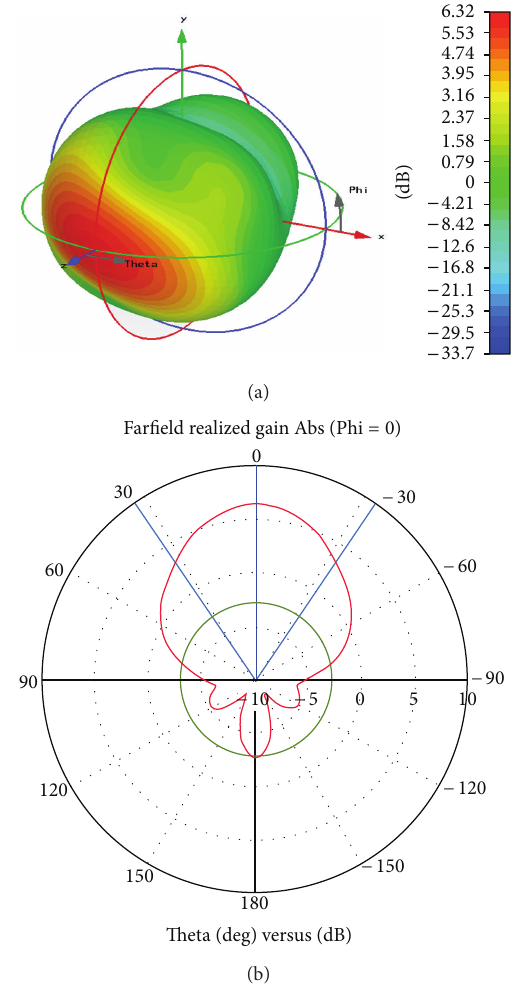
Figure 11: Radiation pattern of Archimedean spiral antenna: (a) 3D and (b) elevation cuts at phi = 0 ∘ .